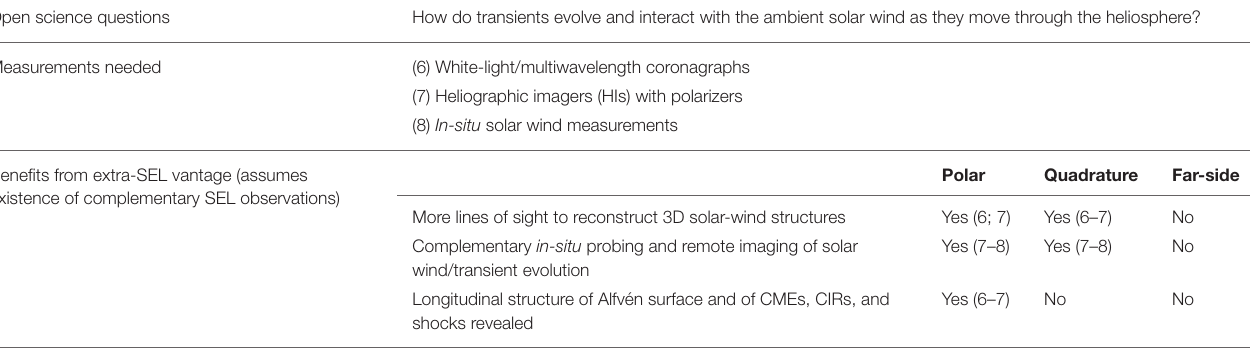
TABLE 3 | Solar-wind/heliospheric transient studies enabled by extra-SEL